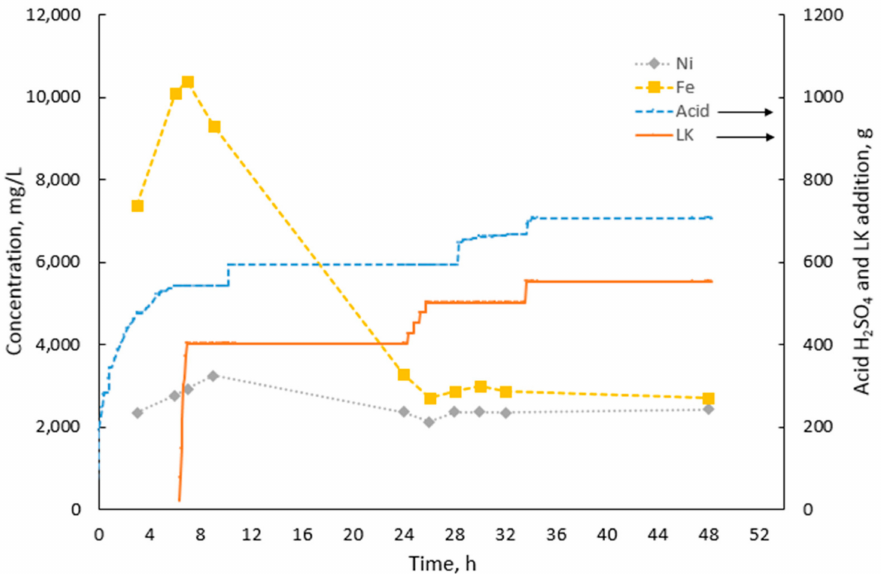
Figure 6. Leaching of LEV for 6 h at pH 0.75, followed by LK laterite addition increasing the pH to 1.8. Concentrations of Ni, Co, Fe, acid, and LK additions. Parameters used in the experiments: 90 ◦ C, S / L = 30%, 800